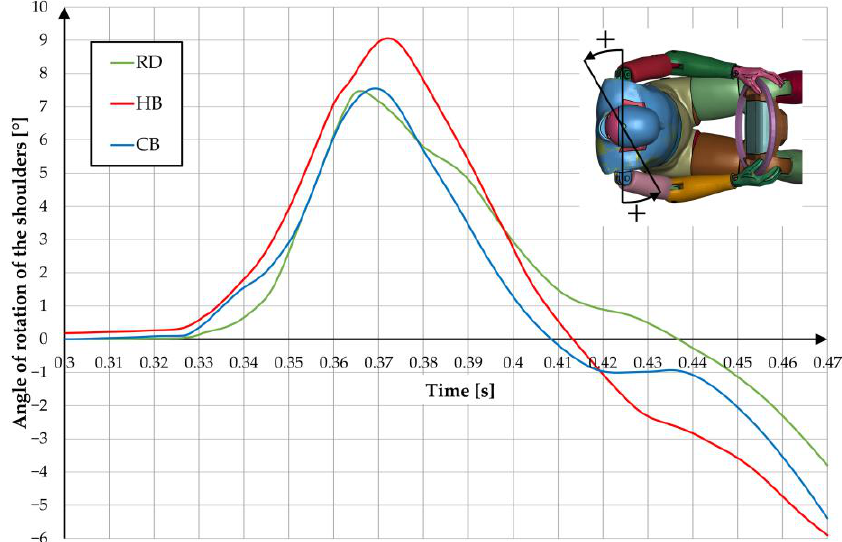
Figure 11. Angle of rotation of the shoulders.